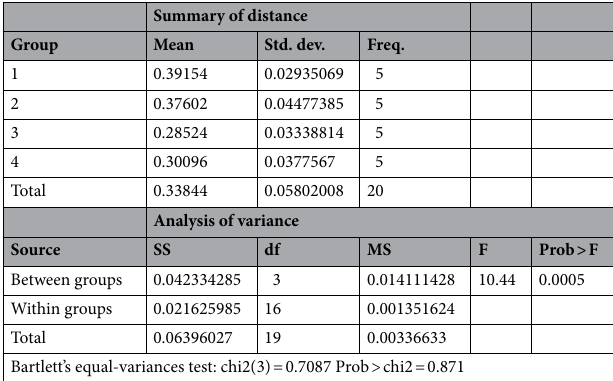
Table 5. Analysis of variance. Group 1 L4L5NS1, Group 2 L5NS1, Group 3 L4L5LS1,Group 4